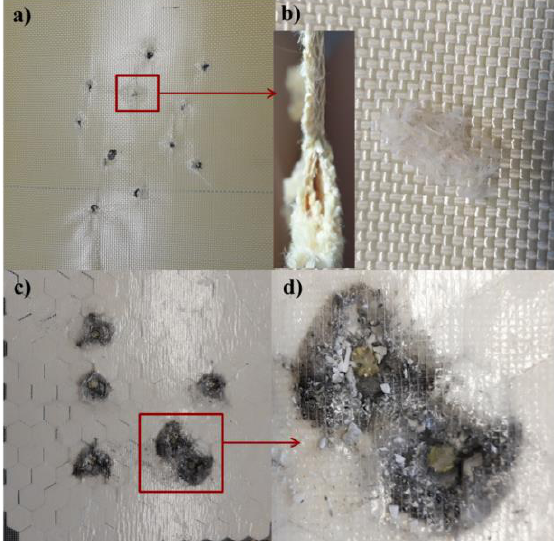
Figure 4. Hard ballistic inserts: Composite type 1 — multilayer hot-pressed Twaron ® CT736 preim- pregnated sheets (shooting side) ( a ); composite type 1 — visible delamination and para-aramid yarn breakage (outlet side of fragment) ( b ); composite type 2 — multilayer hot-pressed Twaron ® CT736 preimpregnated sheets and Al 2 O 3 (shooting side) ( c ); composite type 2 — ceramic elements cracked as a result of the impact of the FSP.22 fragment ( d ).